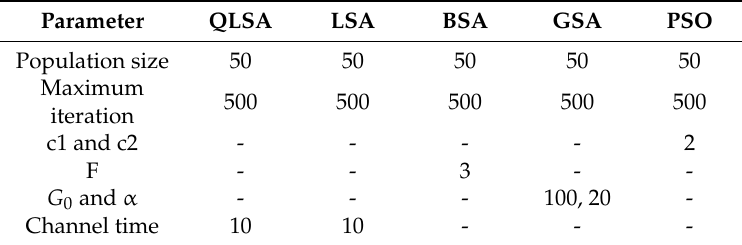
Table 2. Parameter settings used in quantum-behaved lightning search algorithm (QLSA), lightning search algorithm (LSA), the backtracking search algorithm (BSA), the gravitational search algorithm (GSA) and particle swarm optimization (PSO).